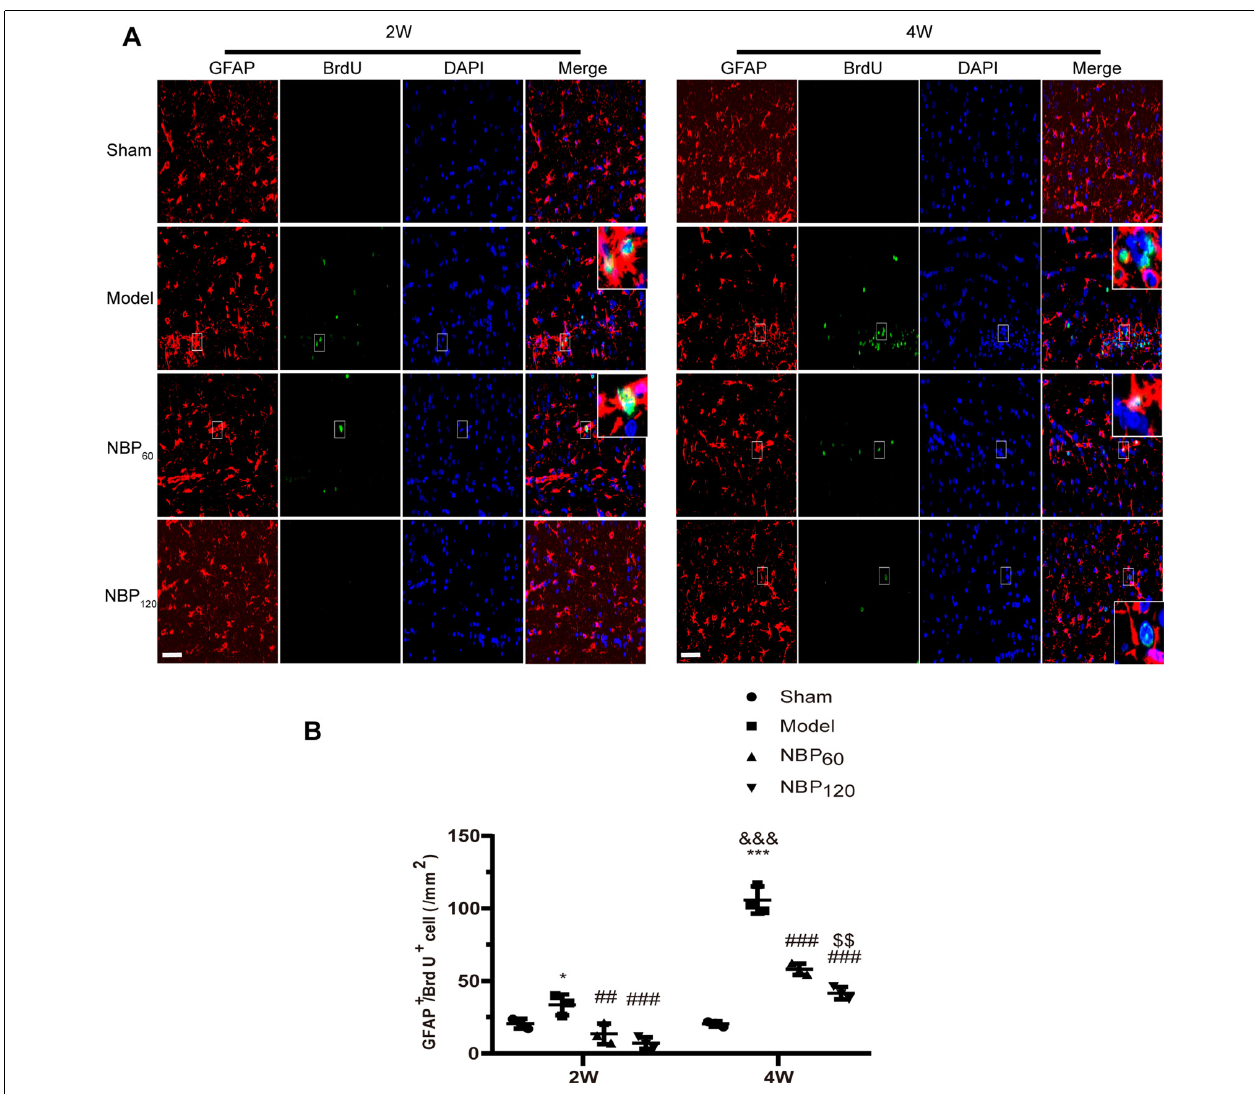
FIGURE 5 | Dl-3-n-butylphthalide (NBP) suppresses astrocytes regeneration after 2VO. (A) Representative images of GFAP (red) and BrdU (green) immunofluorescence double labeling in corpus callosum at 2 weeks and 4 weeks after 2VO. Bar = 50 µ m. Typical double-labeled areas are magnified ( n = 3 in each group). (B) The number of GFAP+/BrdU+ cells in corpus callosum. * p < 0.05, *** p < 0.001, the model group vs. the sham group; ## p < 0.01, ### p < 0.001, the NBP60 group or NBP120 group vs. the model group; $$ p < 0.01, the NBP60 group vs. NBP120 group; &&& p < 0.001, the model group sacrificed at 2 weeks vs.